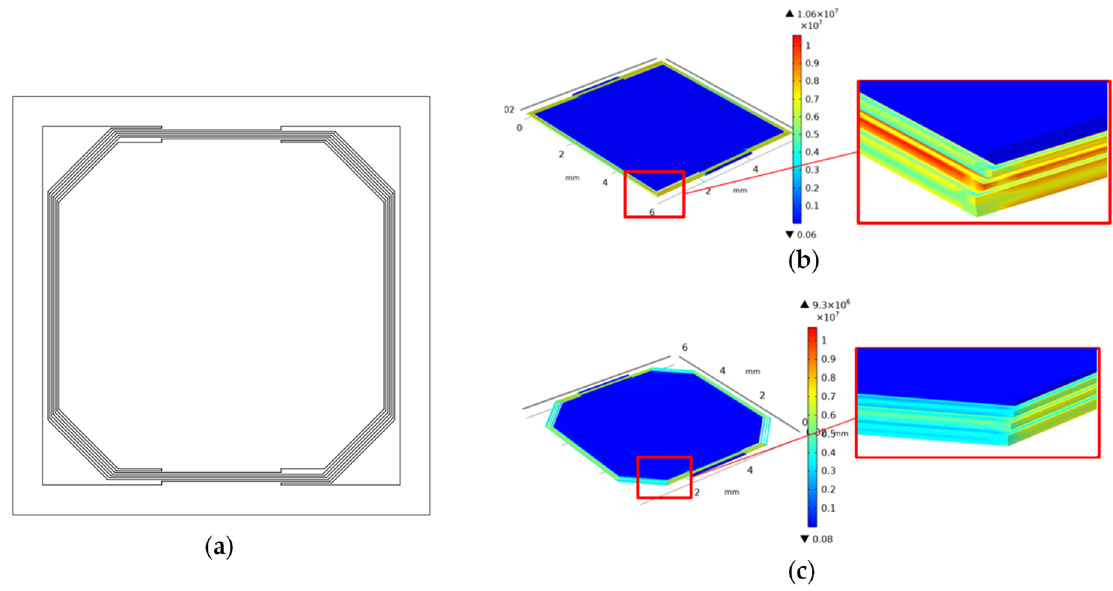
Figure 6. ( a ) Square spiral pattern with chamfers at the corners; ( b ) simulation results of the stress distribution of the square spiral pattern; ( c ) simulation results of the stress distribution of the square spiral pattern with the chamfers at the beam corners.